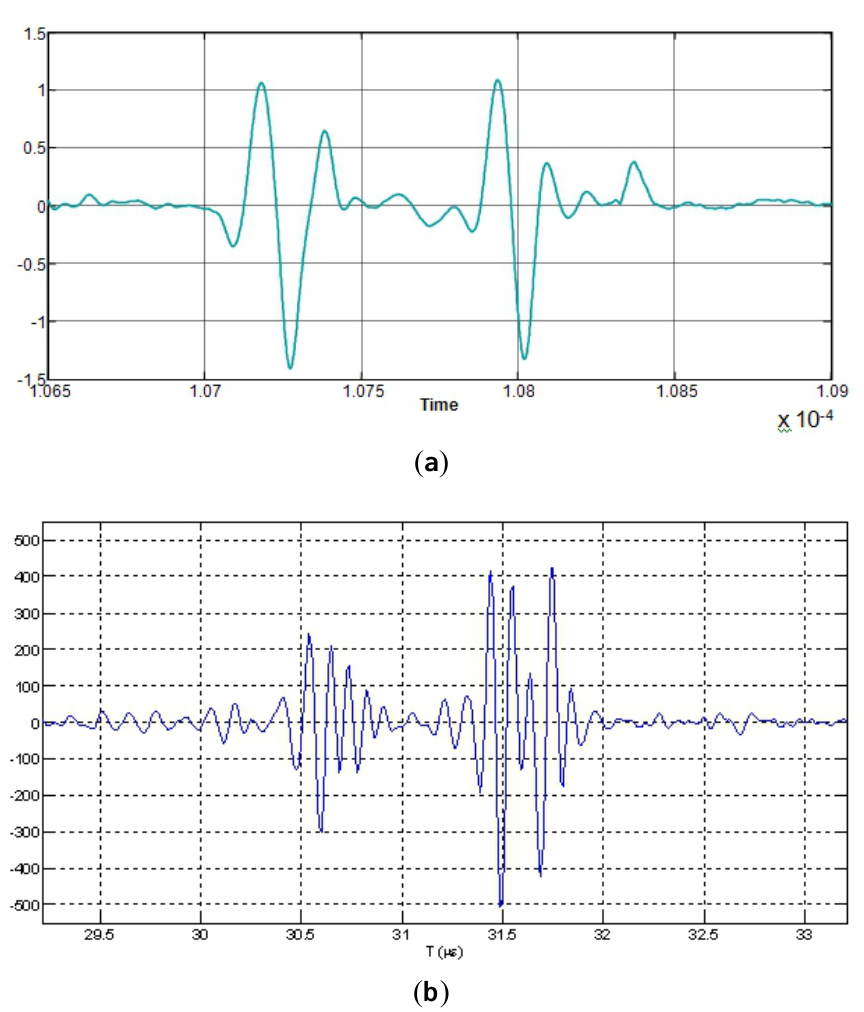
Figure 6. Examples of echo-signals measured with broadband ultrasonic transducers of central frequency f = 10 MHz: ( a ) from a phantom made with two layers of latex; ( b ) from 0 a femoral artery